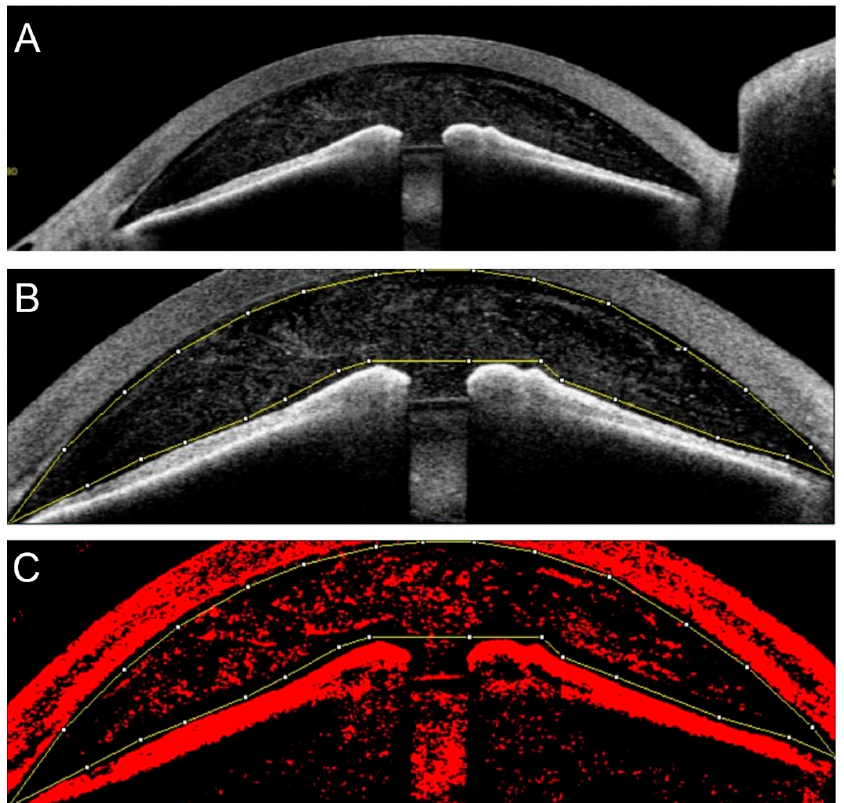
Figure 2. Quantification of anterior chamber particles. A horizontal image obtained by AS-OCT was imported into the ImageJ program ( A ). The interior of the anterior chamber was manually outlined as widely as possible with ImageJ ( B ). Then, the image was binarized using “bernsen” in “auto local threshold” mode, and the ratio of the particles in the anterior chamber to the total area of the anterior chamber was calculated ( C